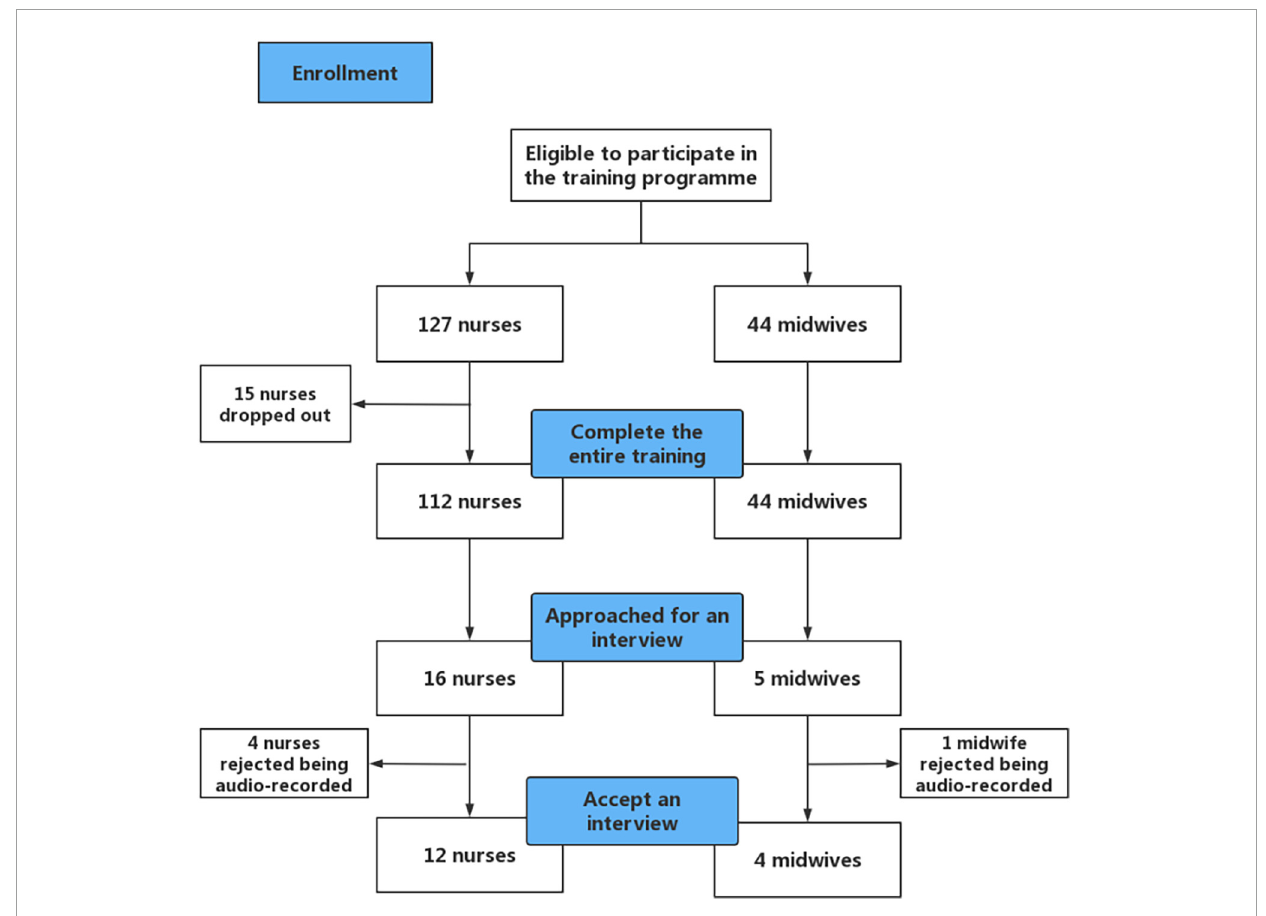
FIGURE1 Flow diagram of participants’